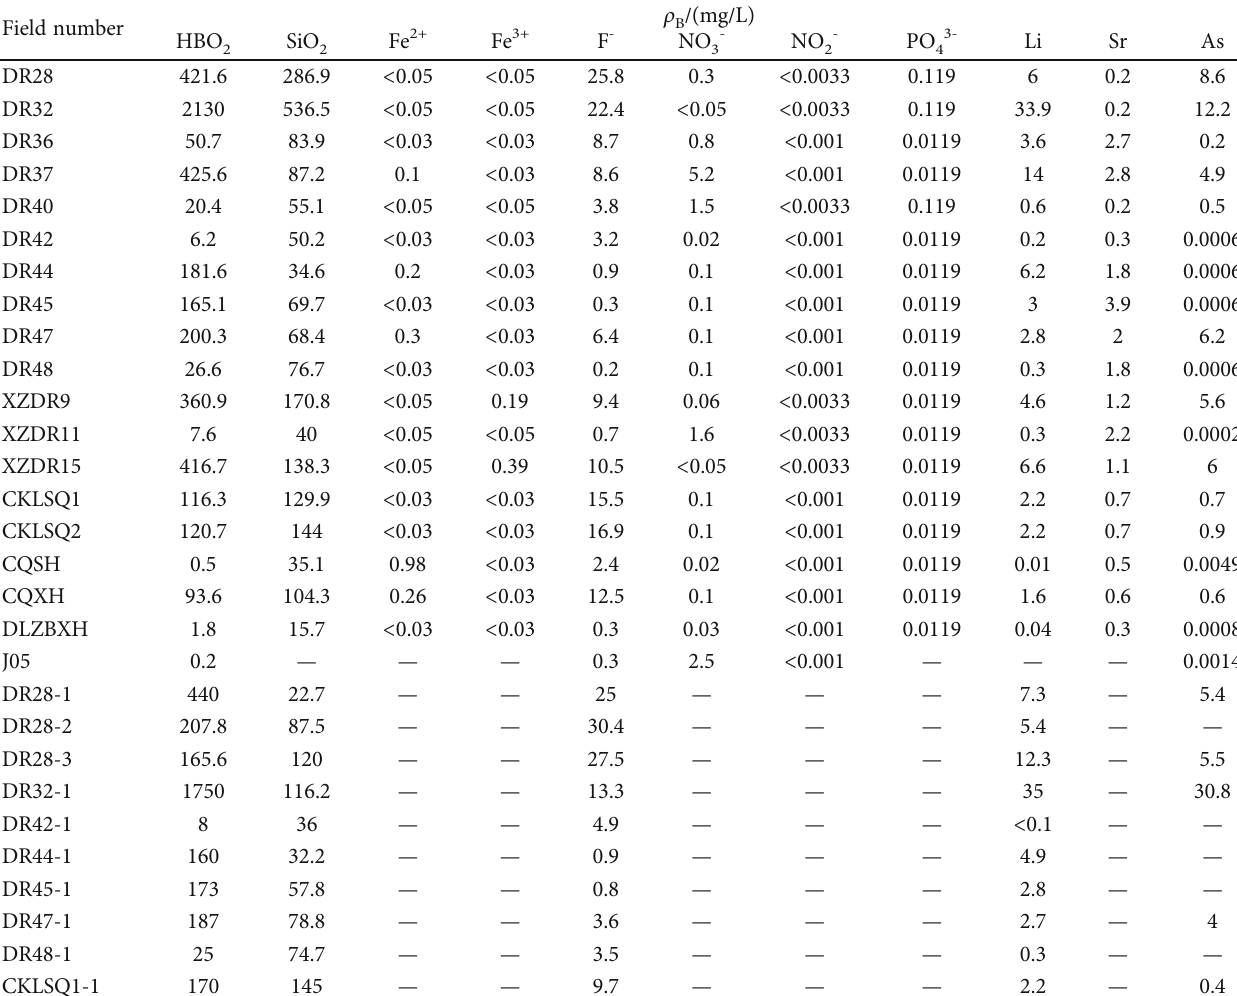
Table 2: Trace components of the water samples in the study